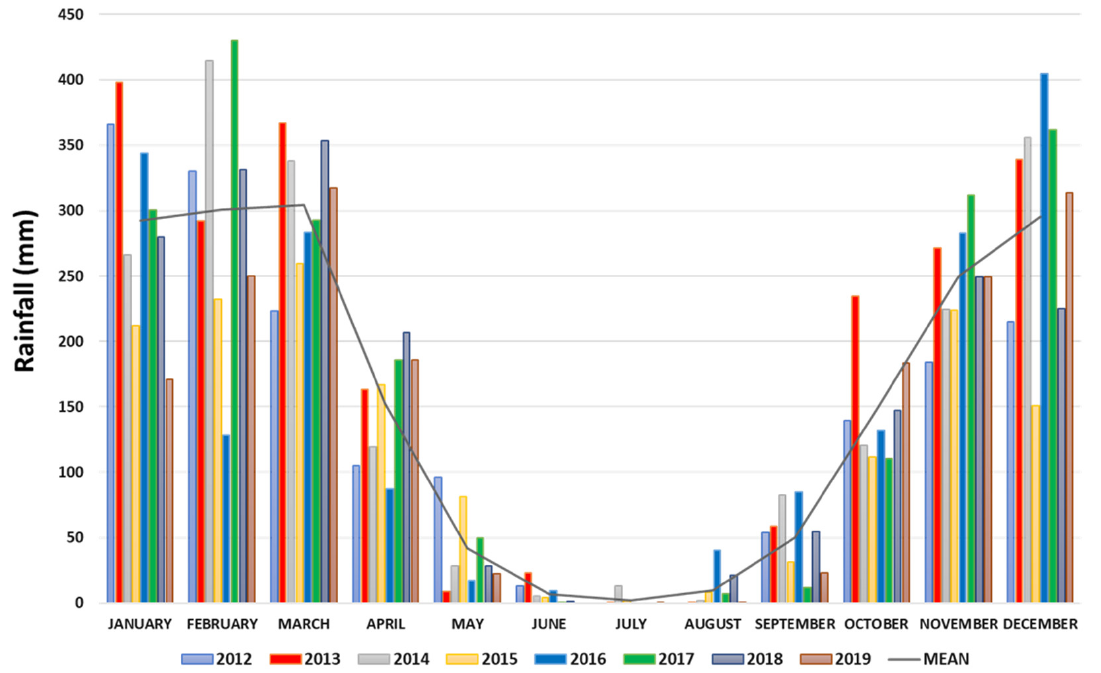
Figure 2. Histogram depicting monthly rainfall distribution for Mato Grosso in different years.